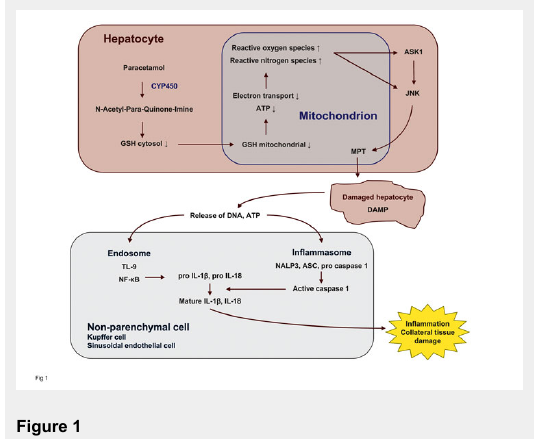
Model of paracetamol hepatotoxicity. Paracetamol impairs mitochondrial function via formation of a reactive metabolite and depletion of glutathione. The resulting oxidant stress activates a redox-sensitive kinase (ASK1) and subsequently a cell-death promoting kinase (JNK). The latter translocates to mitochondria and promotes the mitochondrial permeability transition (MPT). The damaged hepatocytes release danger signals (danger associated molecular pattern, DAMP) which via their interaction with the endosome and inflammasome generate an innate immune response by non-parenchymal